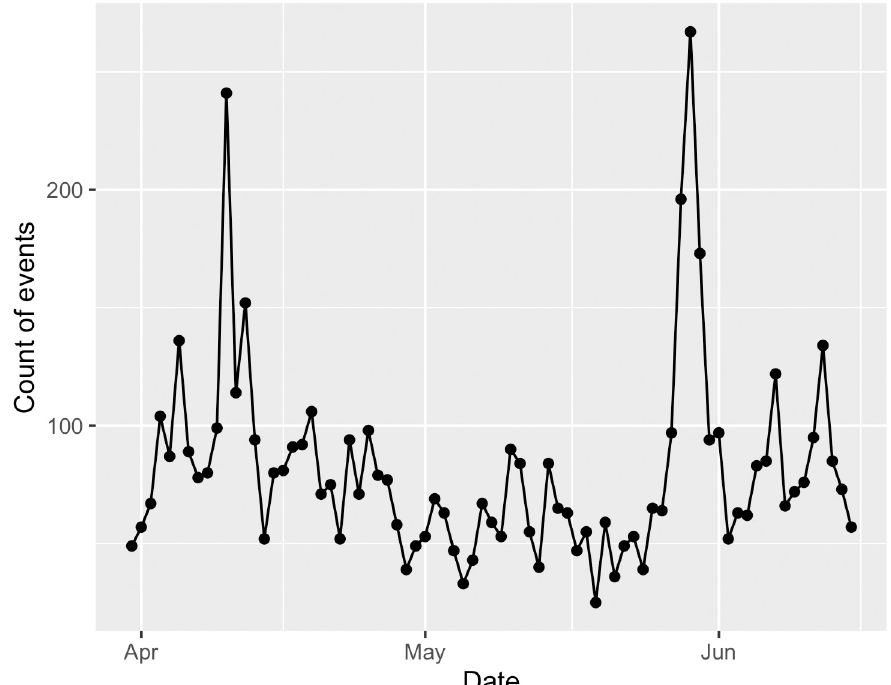
Fig 6. Example of pre-processed